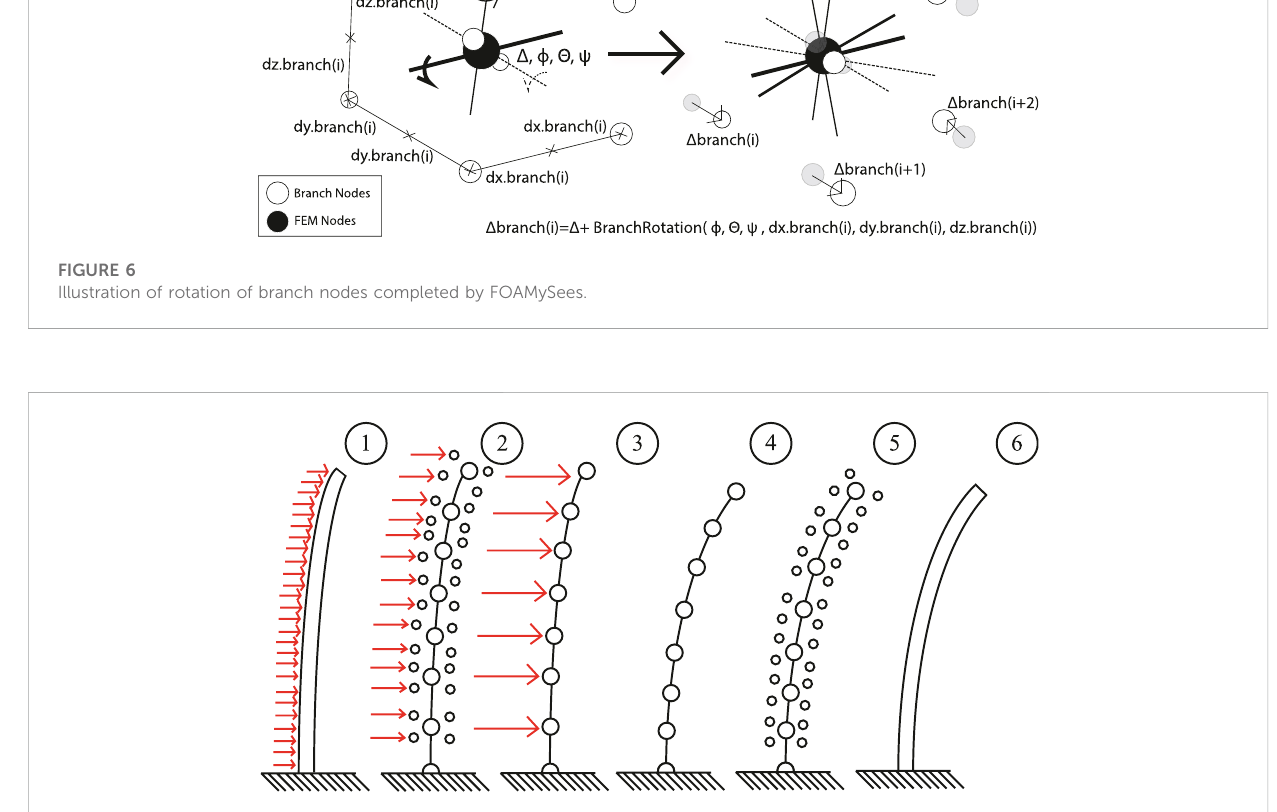
Conceptual evolution of branch node interpolation to FEM nodes and back. (1) Calculation of pressures (OpenFOAM). (2) Interpolation of surface pressures to branch nodal forces (preCICE). (3) 1D interpolation of branch forces for FEM nodes (FOAMySees). (4) Evolution of the structural model over one timestep (OpenSeesPy). (5) Interpolation of FEM nodal displacements and rotations to branch nodes (FOAMySees). (6) Interpolation of branch node displacements to CFD surface patch nodes